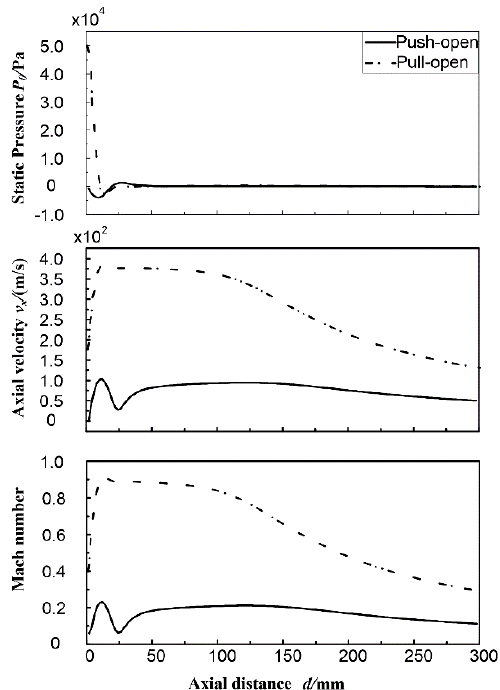
Figure 13. The pressure, velocity and Mach number distribution on the outflow centerline of injector.